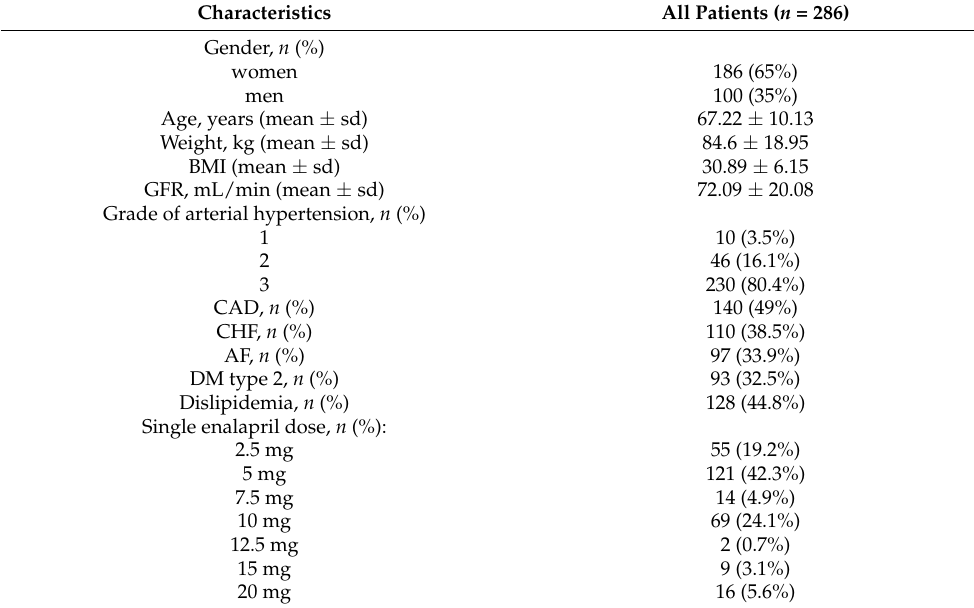
Table 1. Baseline characteristics of